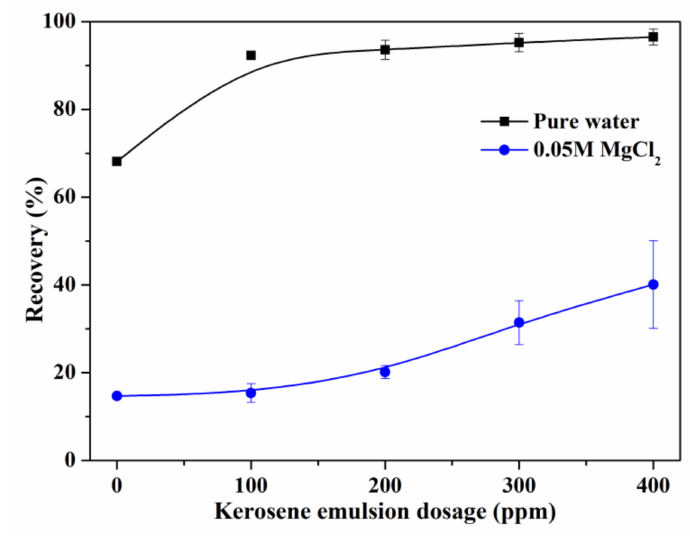
Figure 1. Chalcopyrite recovery as a function of kerosene emulsion dosage, at pH 10.